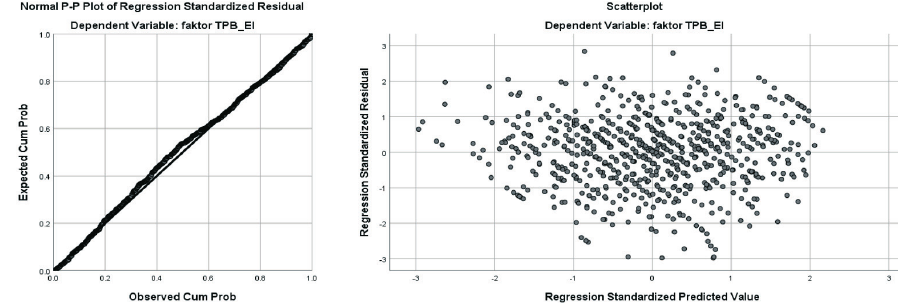
Fig. 2 – Normal P-P plot (left). Scatterplot (right). Source: own